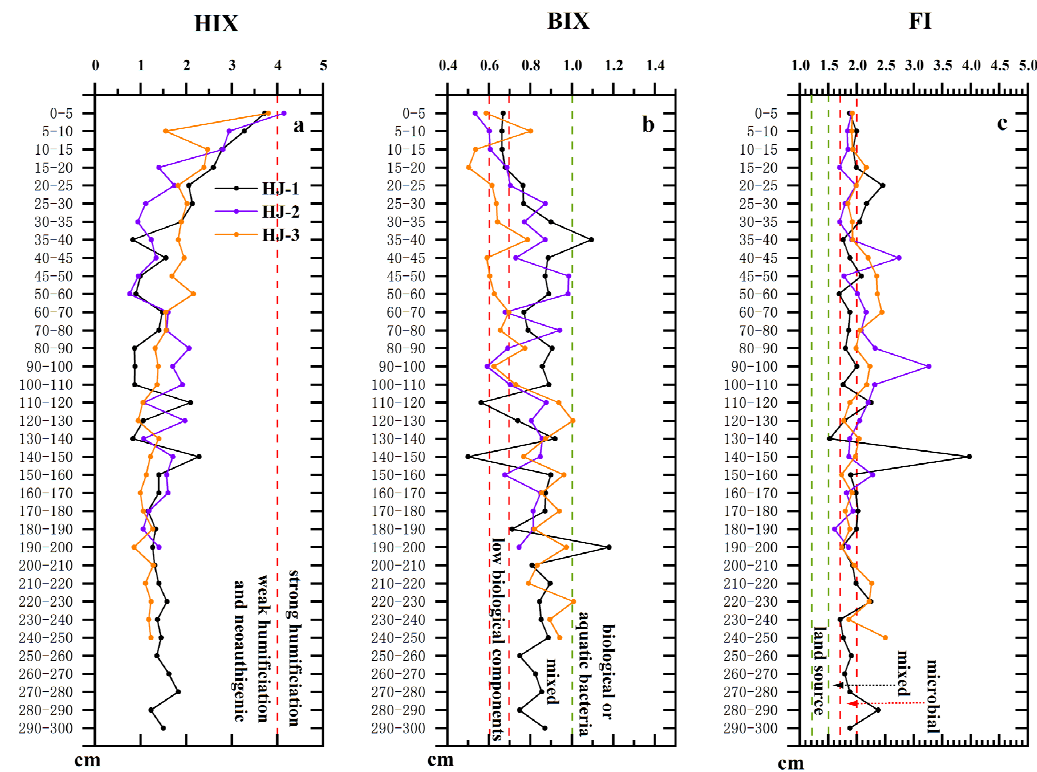
Figure 4. The content of HIX ( a ), BIX ( b ), and FI ( c ) in each layer of fissure soil.